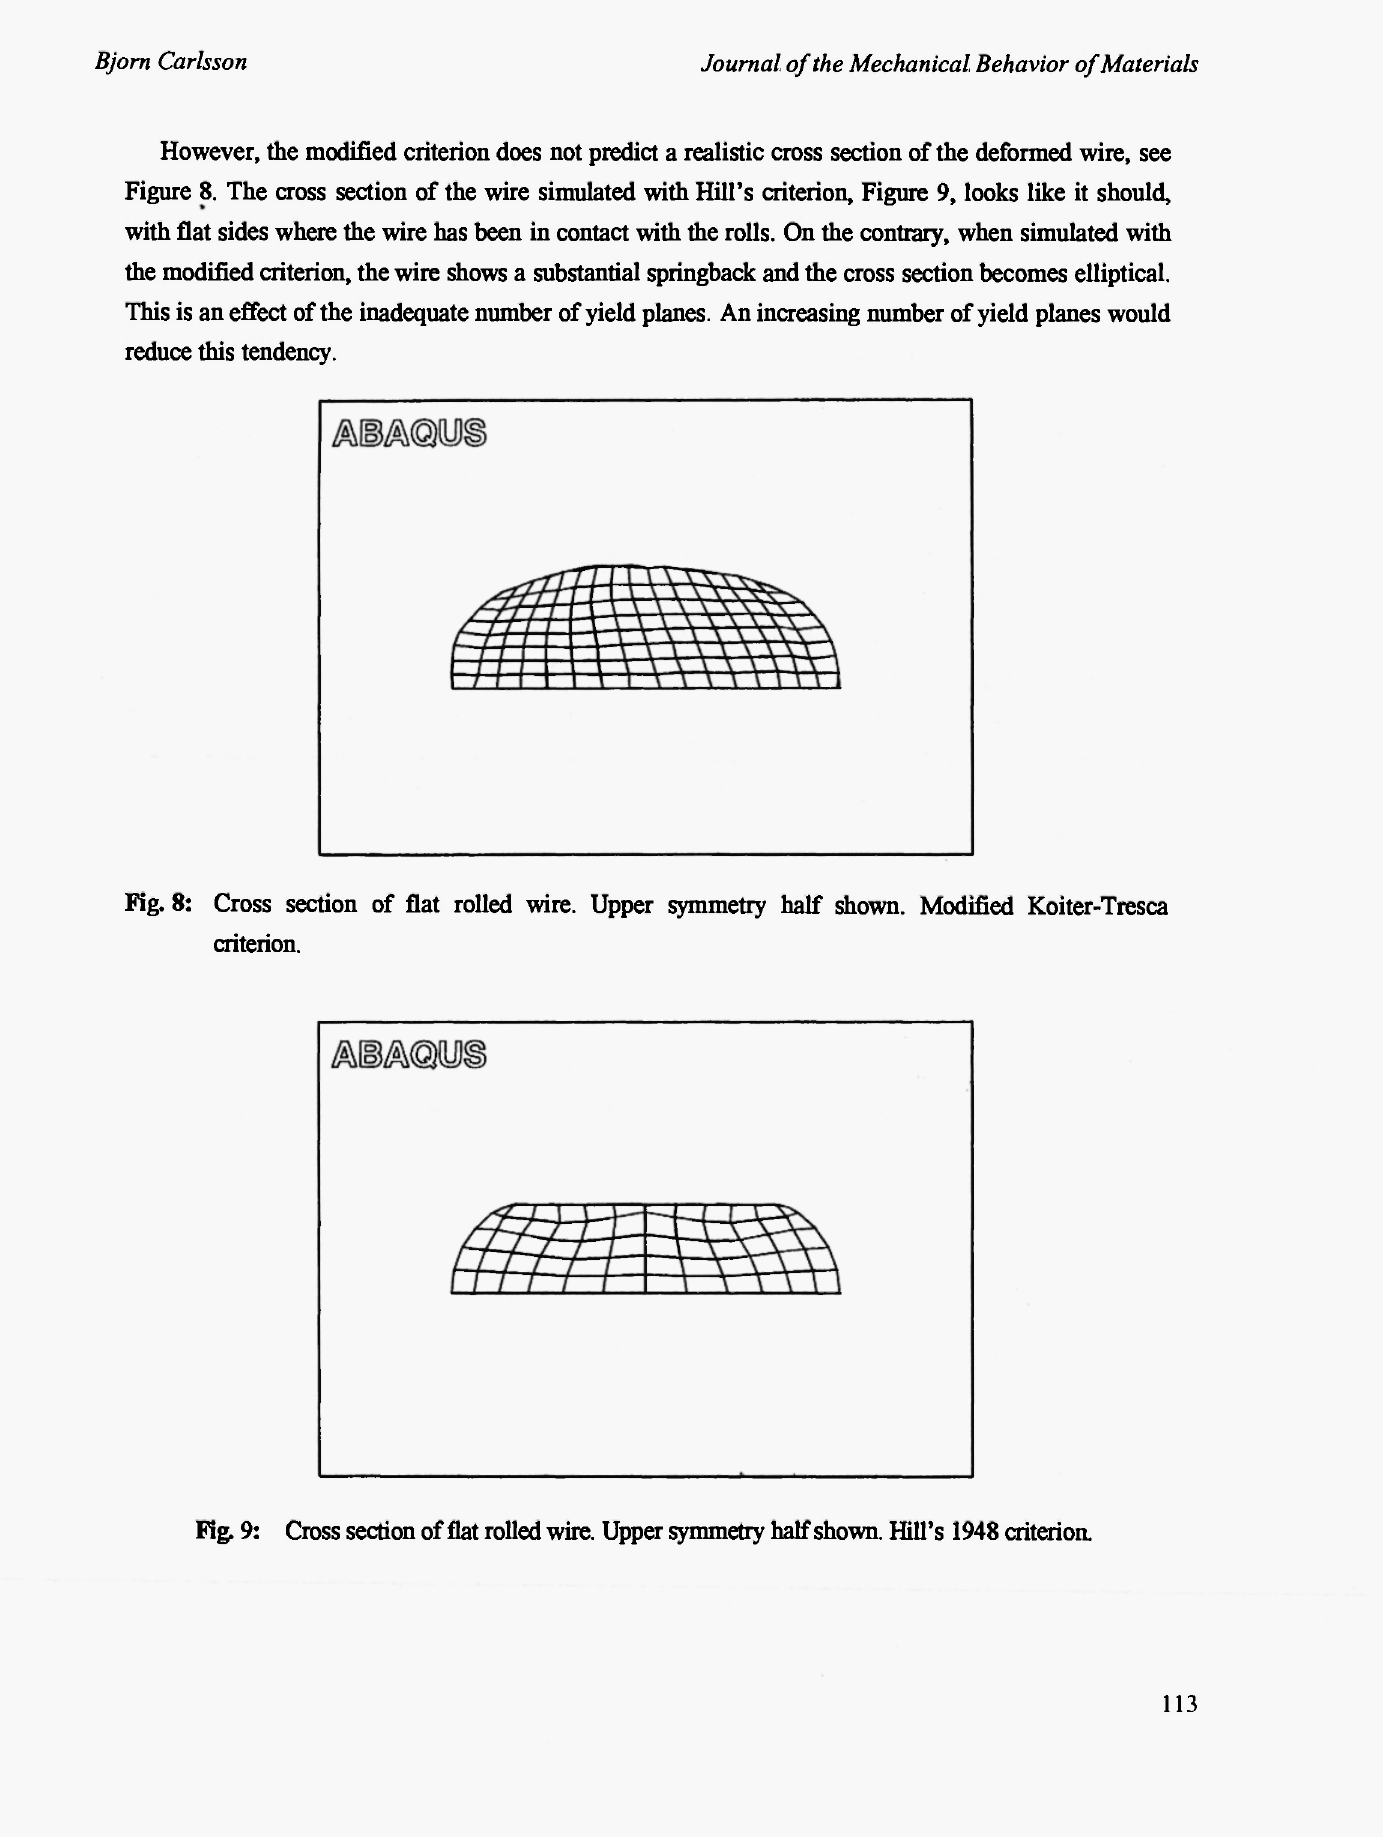
Fig. 8: Cross section of flat rolled wire. Upper symmetry half shown. Modified Koiter-Tresca criterion.